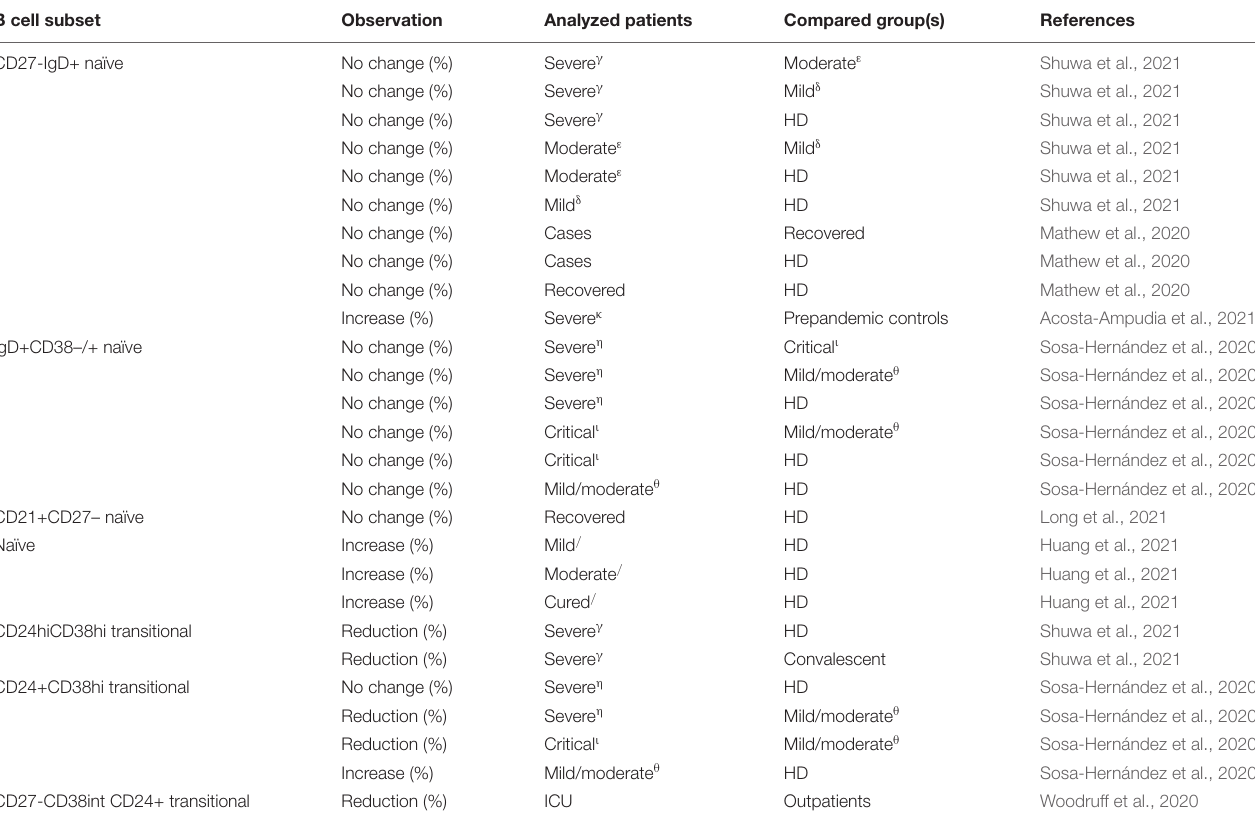
TABLE 6 | Observed fluctuation in naïve and transitional B cells in adult COVID-19